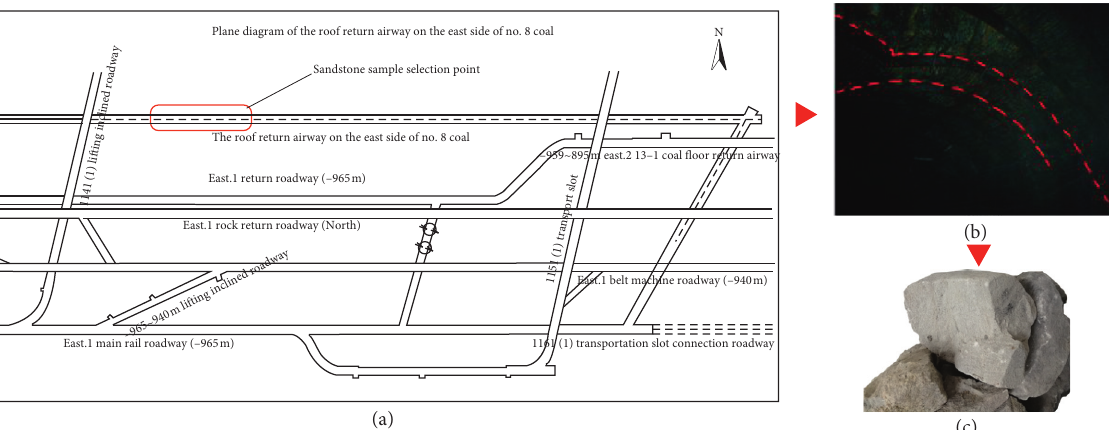
Figure 1: Sandstone specimens selection location: (a) plane diagram of the roof return airway on the east of the no. 8 coal, (b) roadway real scene, and (c) appearance of the rock